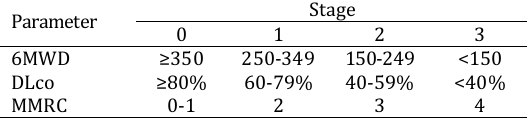
Table 1. The EDD index in scleroderma lung